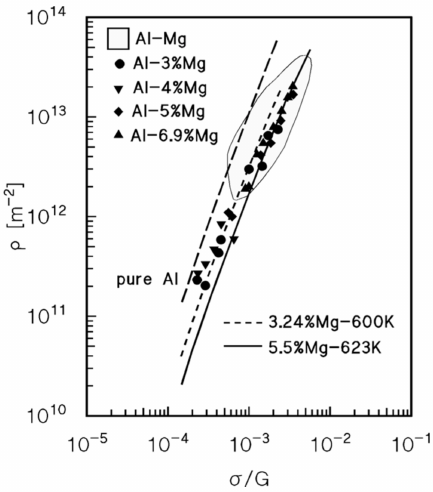
Figure 3. Experimental values of the dislocation density as a function of stress for Al-3%Mg [20–22], Al-4%Mg [21], Al-5%Mg [21], and Al-6.9%Mg [20]. The shaded area, which illustrates the scatter band for Al-Mg alloys, was reported in [22]. The Figure also plots the model curve for pure Al [13] and for Al-Mg alloys (3.24% and 5.5%Mg at 600 and 623 K,